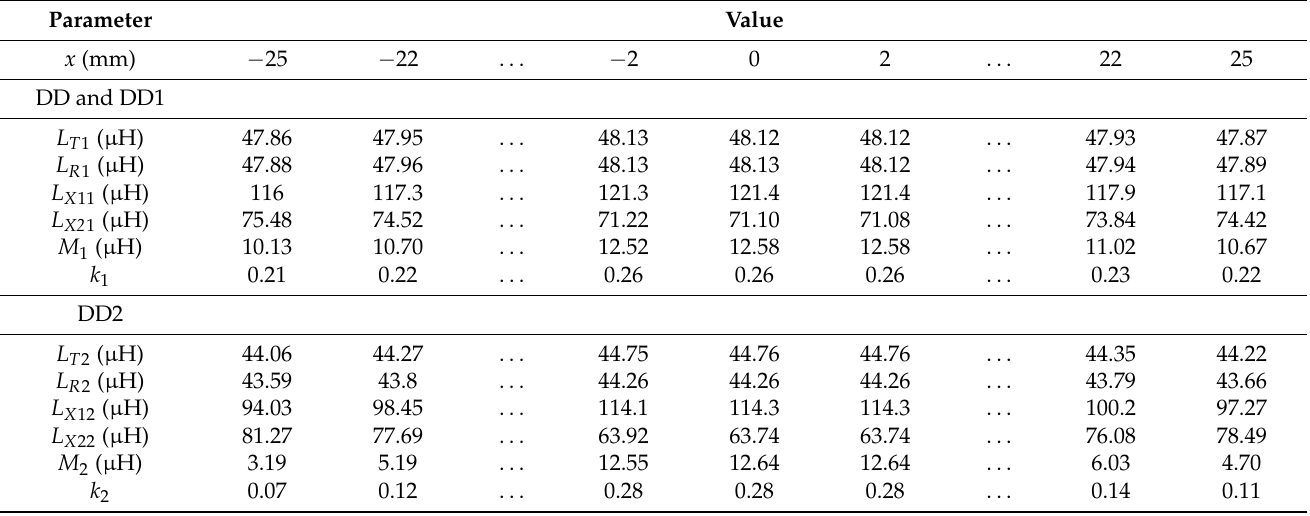
DD coil when the coil is perfectly aligned along the x -axis ( x = 0 mm). Table 3. Coupling coefficient measurements of the DD (DD1) and DD2 coils in the x -axis at y = 0 and z = 25.3 mm. Parameter